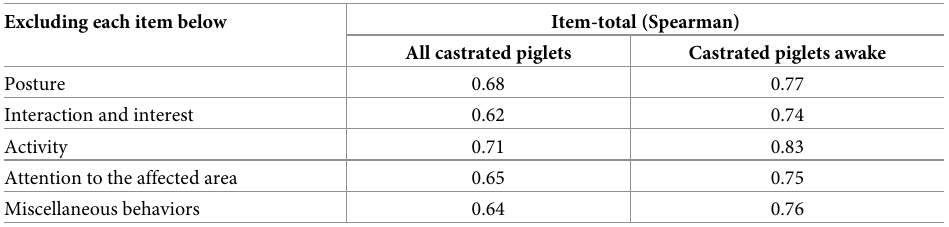
Table 5. Item-total correlation of the UPAPS applied for all castrated piglets (n = 39). Excluding each item